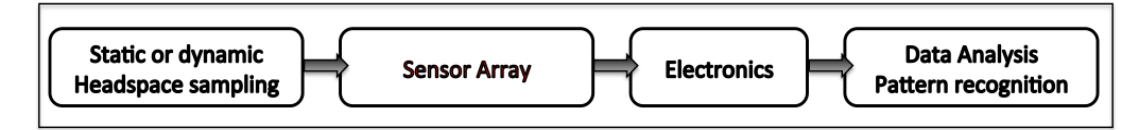
Figure 9. Schematic of the four main building blocks of an